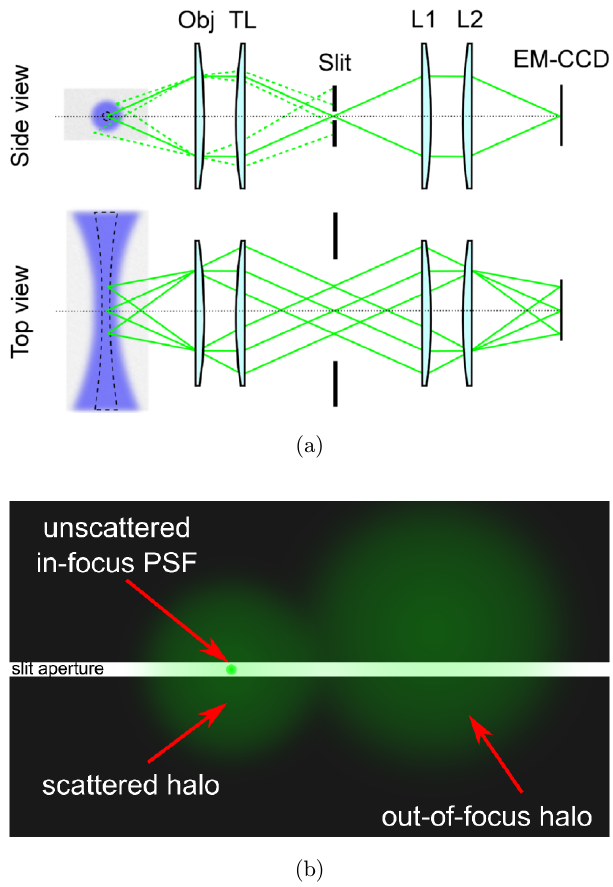
Fig. 3. CLSM operating principle. In (a) side (upper panel) and top (lower panel) views of the spatial ¯lter operation scheme. The di®raction limited excitation beam (black dashed line) is blurred (blue area) because of sample-induced scatter- ing. The °uorescence light is then emitted both in-focus (green continuous lines) and out-of-focus (green dashed lines): only the in-focus ballistic photons are properly focused in the aperture of the spatial ¯lter (Slit) by the ¯rst 4f optical system (objective, Obj and tube lens, TL). The second 4f system (L1, L2) images ballistic photons on the EM-CCD sensor. In (b) view of the slit plane [black line in (a)]. In-focus unscattered °uorescence emission is correctly focused into the slit, whilst both scattered and out-of-focus light forms a wide halo which lies almost completely outside the aperture and is therefore blocked.